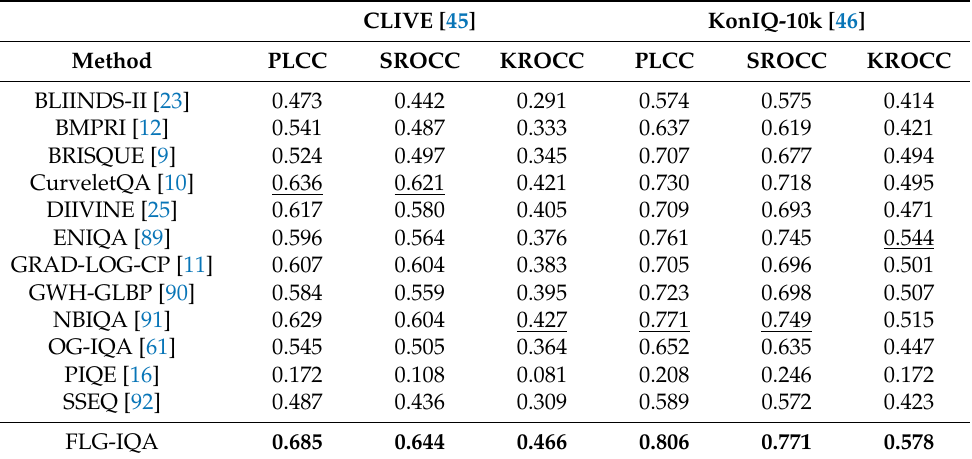
Table 7. Comparison to the state-of-the-art in CLIVE [45] and KonIQ-10k [46] databases. Median PLCC, SROCC, and KROCC values were measured over 100 random train–test splits. The best results are in bold and the second-best results are underlined.